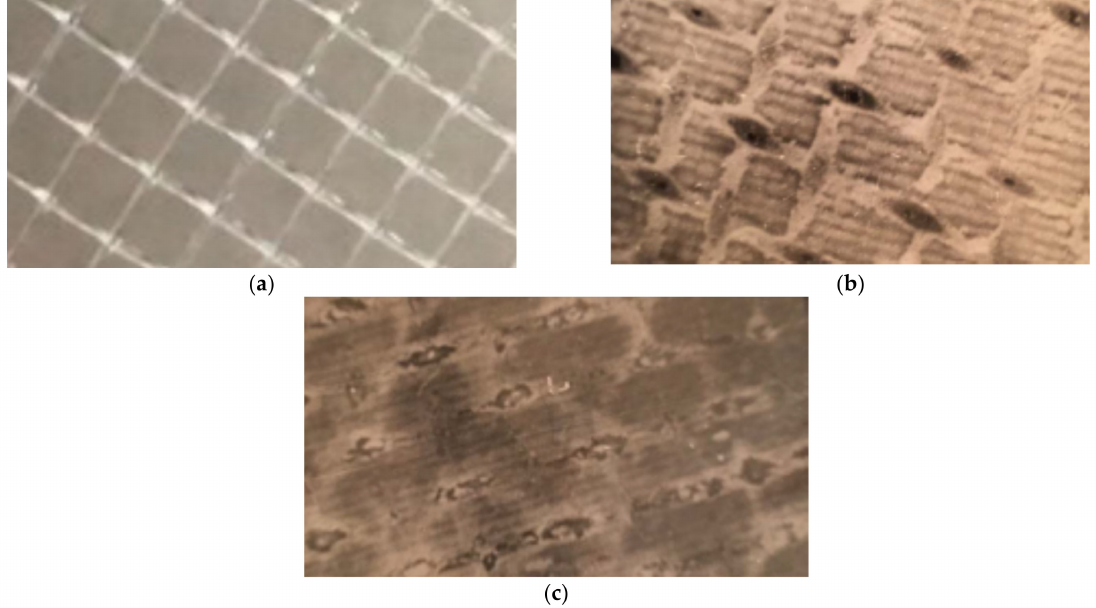
Figure 1. Formation of “dead areas” on membrane surface in spiral wound elements: ( a ) spacer mesh; ( b ) membrane surface in the beginning of scaling; ( c ) membrane surface covered by calcium carbonate scale layer.